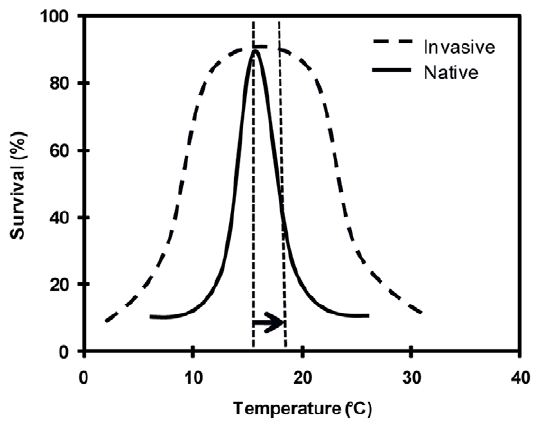
Figure 1. Conceptual model of greater invasive eurythermality. If an invasive (dashed line) has a broader range or higher limit of temperature tolerance than a native (solid line) then an increase in temperature (illustrated by a shift from the left to the right vertical dashed line) is likely to have a disproportionately negative impact on the native species. This physiological mechanism has the potential to precipitate changes in community composition, with increases and decreases in invasive and native relative abundance, respectively.